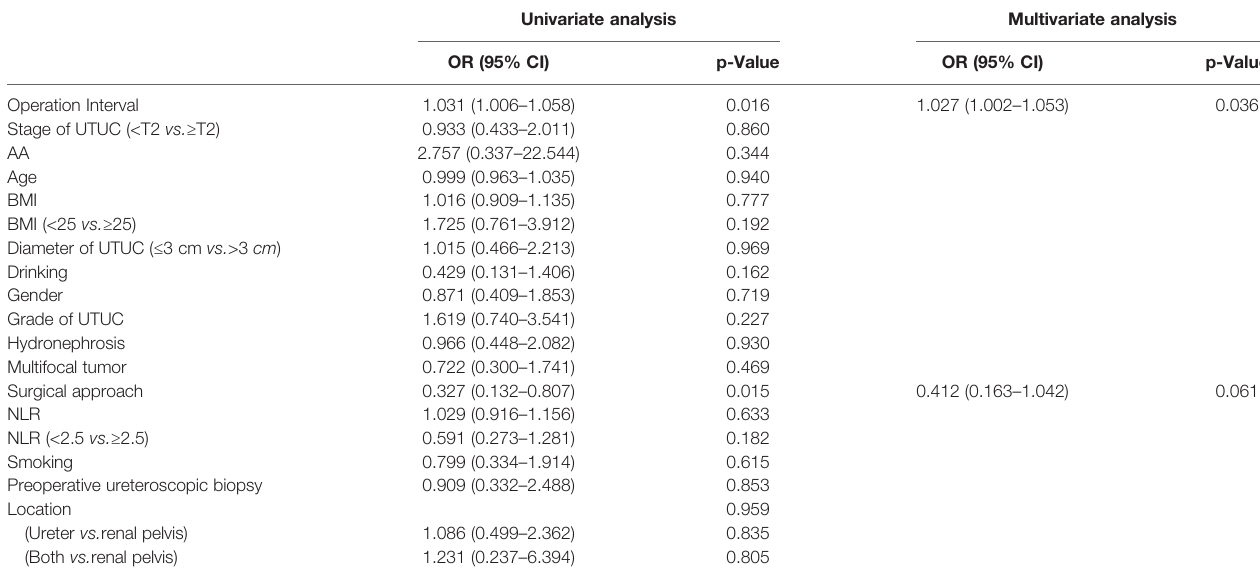
TABLE 7 | Univariate and multivariate analyses for factors associated with BC with at least one unfavorable pathological type after